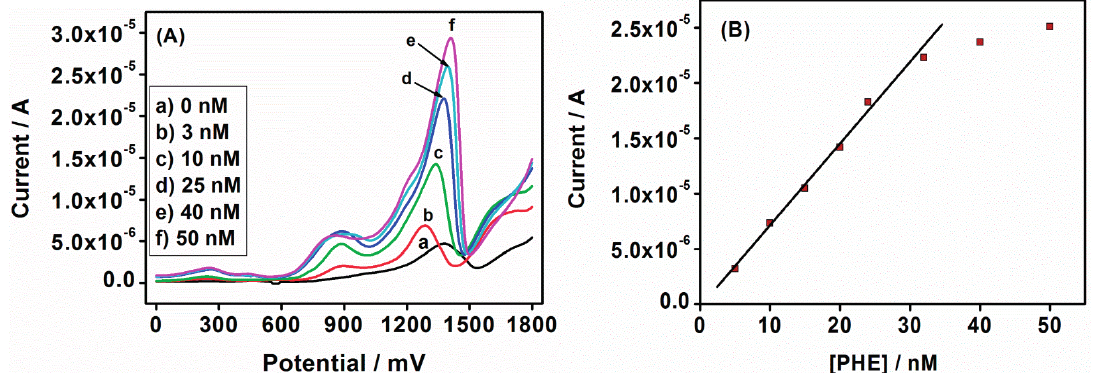
Figure 8. ( A ) SWV voltammograms of the Au|G3PPT-co-P3HT in 0.1 mol/L Bu 4 NClO 4 /CH 3 CN/H 2 O with different PHE concentrations; ( B ) The calibration plot of Au|G3PPT-co-P3HT sensor for PHE (experimental conditions were: the SW frequencies = 5 Hz, scan increment E s = 2 mV and SW amplitude of E s w = 25